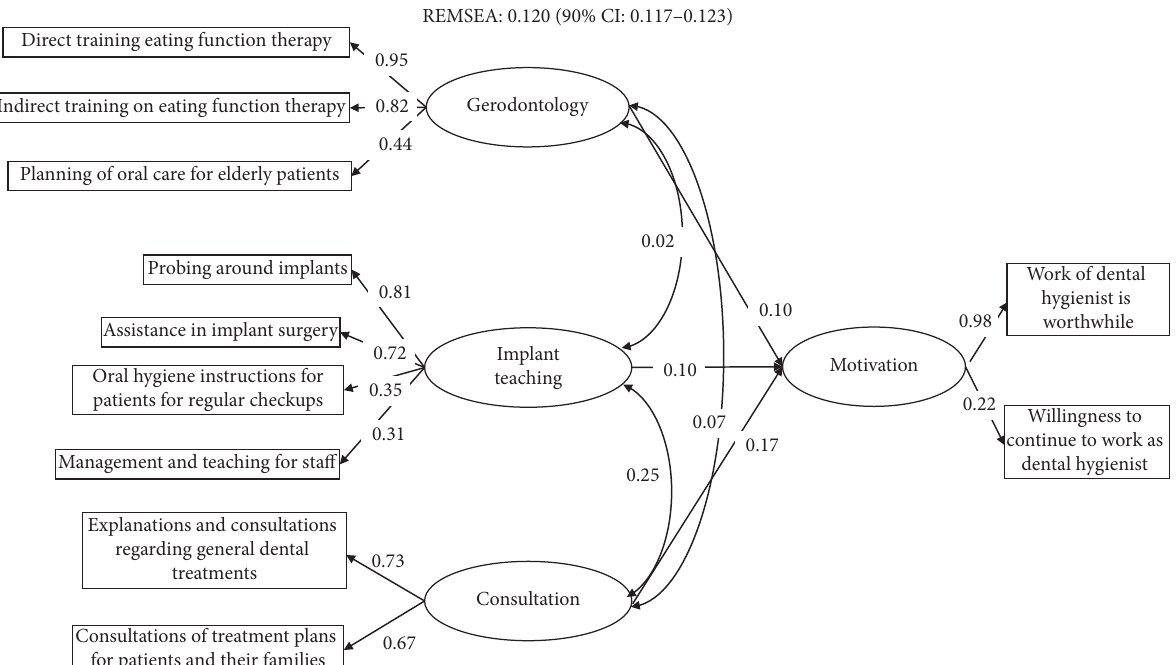
Figure 2: Path diagram of the motivation of dental hygienists based on the work-related tasks. All paths were statistically significant. The fitness index, which was calculated as REMSEA, was